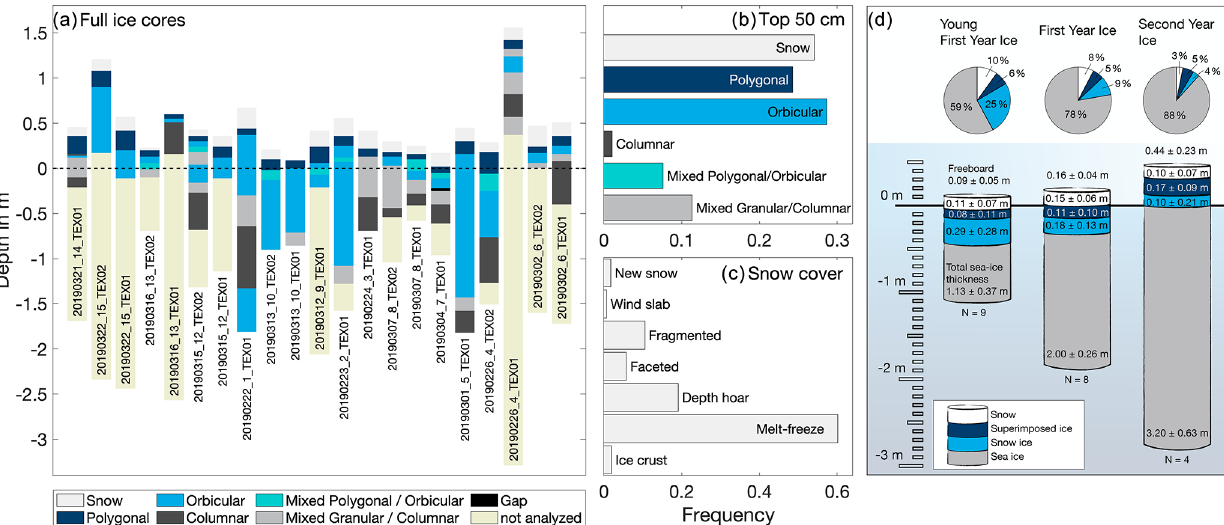
Figure 3. (a) Overview of all sampled ice cores colored with the respective crystal texture. Ice cores are ordered according to their sampling location from north (left) to south (right; see Fig. 1). Ice core tags are composed of the respective ice station and the ice texture (TEX) core number. Beige-colored parts were not analyzed for texture. Ice core freeboard and draft are plotted relative to the water level ( z = 0cm, dotted black line). (b) Relative frequency distribution of ice texture classes of the surface ice cores – including only cores with more than 50cm of ice texture information (15 out of 21 ice cores). (c) Relative frequency distribution of snow grain types in all snow pits. (d) Summary of average relative and absolute proportions of snow, superimposed ice, and snow ice in total sea ice thickness (sea ice thickness plus snow depth) of all sampled young first-year, first-year, and second-year ice cores. Averaged ice cores are plotted relative to the water level ( z = 0cm, black